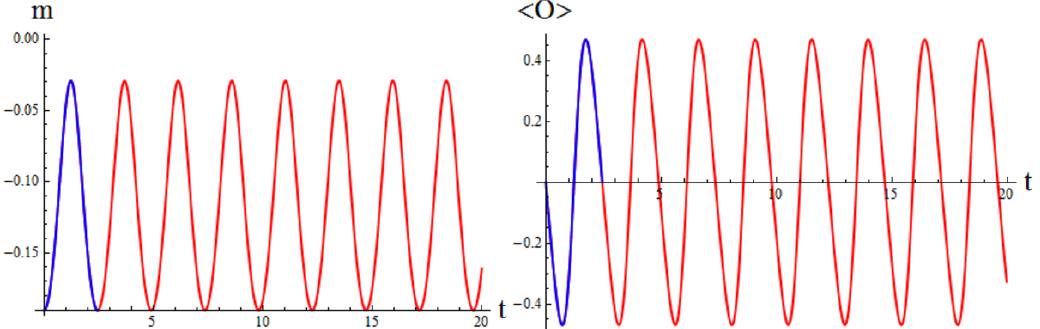
Figure 7 . Energy density and vev for an exactly periodic solution with (cid:11) b = 0 : 45, (cid:21) = (cid:0) 0 : 45 as obtained from the pseudospectral generating code (blue) and the simulated time evolution of the initial data